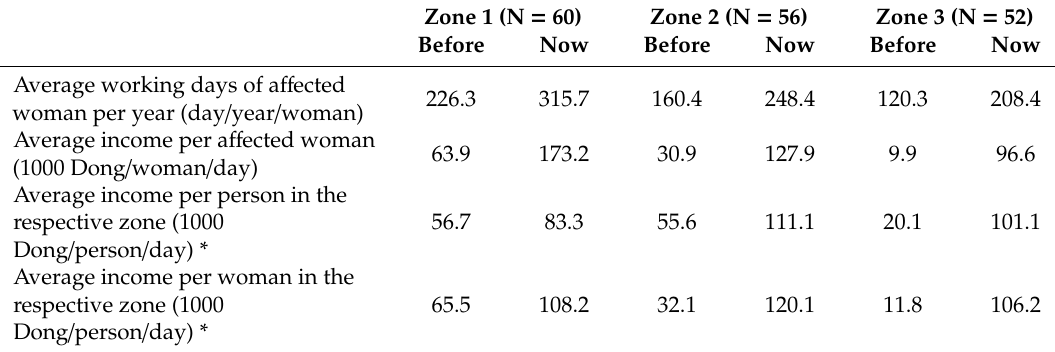
Table 5. Income of rural women before ALA and at